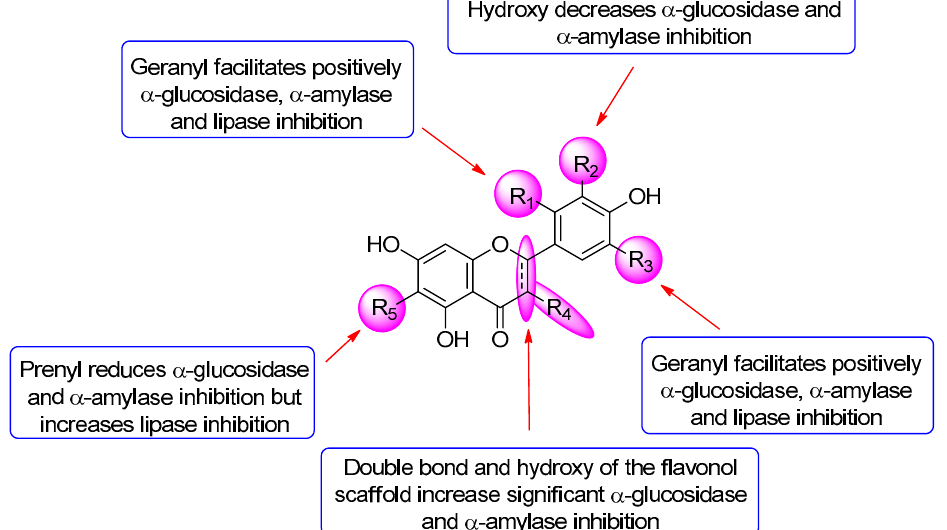
Figure 3. Structure activity relationship of flavonoids in this study. Table 3. An overview of the biological properties of the six compounds isolated from the Queens- land propolis.